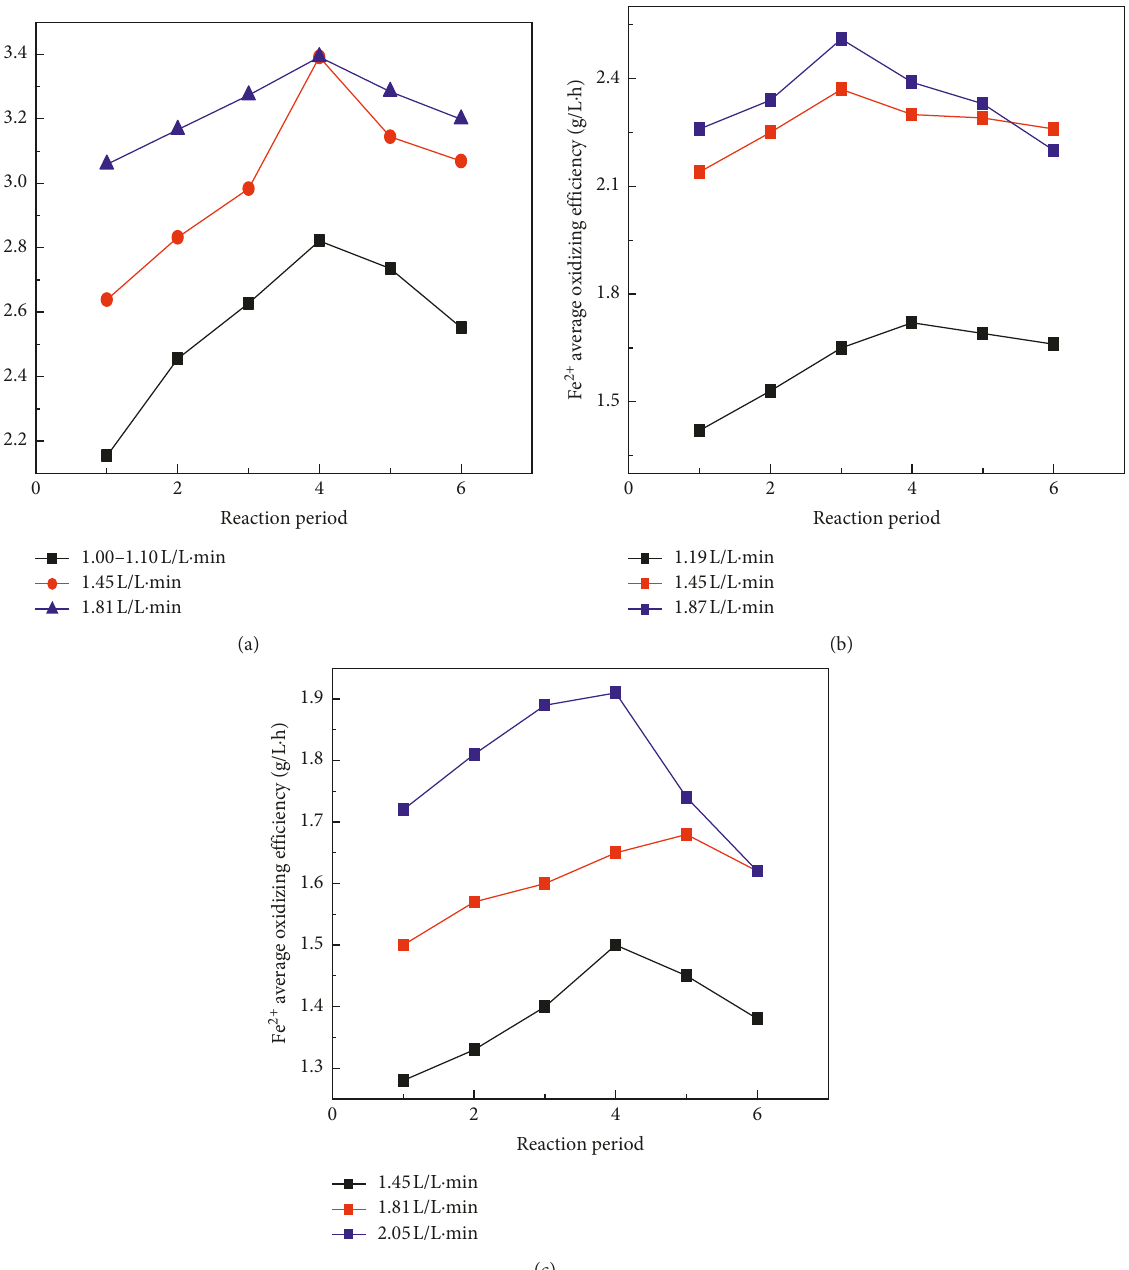
Figure 7: Effect of aeration on the production efficiency of BPFS: (a) 40kg/m 3 BPFS; (b) 60kg/m 3 BPFS; (c) 80kg/m 3